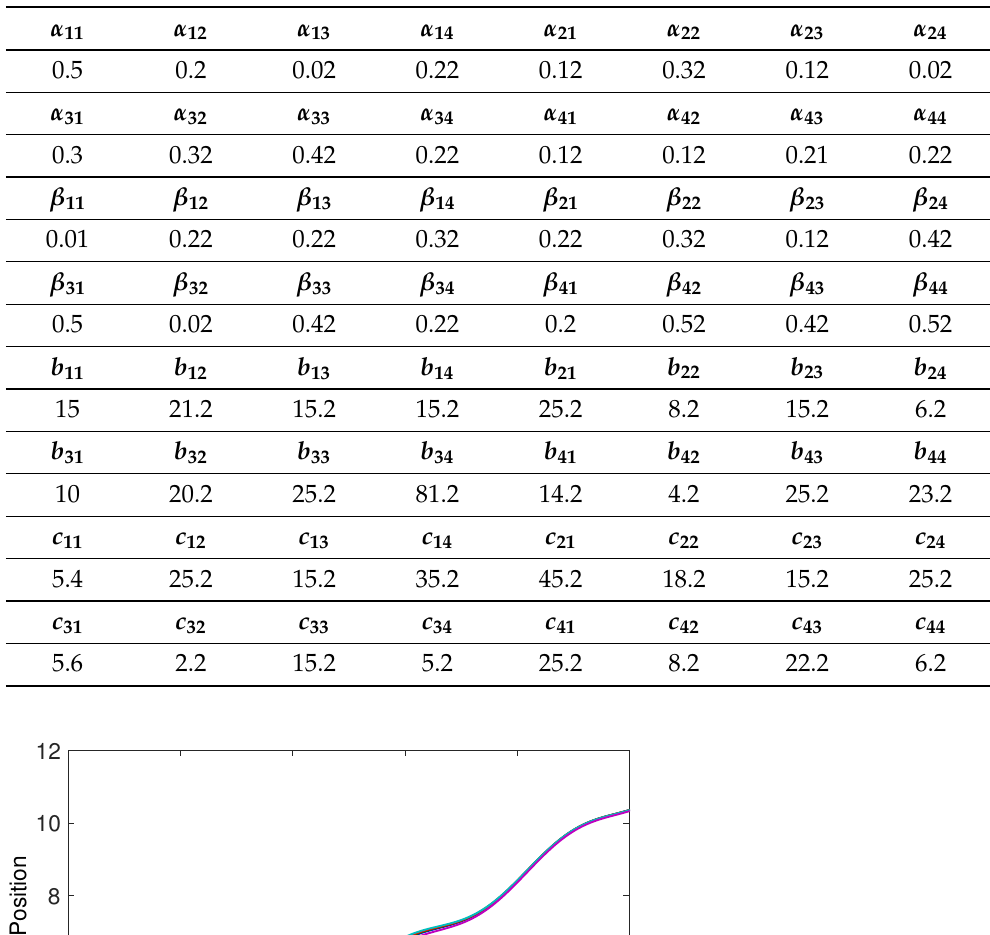
Table 1. Parameters of the controllers used in the simulation.